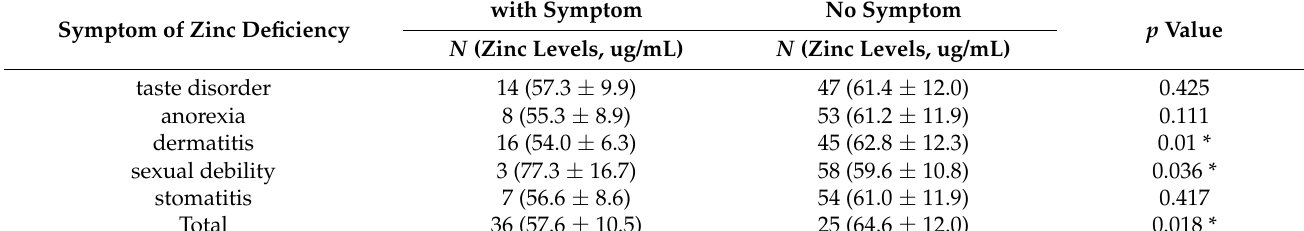
Table 2. Association of Zinc Deficiency Symptoms and Serum Zinc Levels in PD patients.